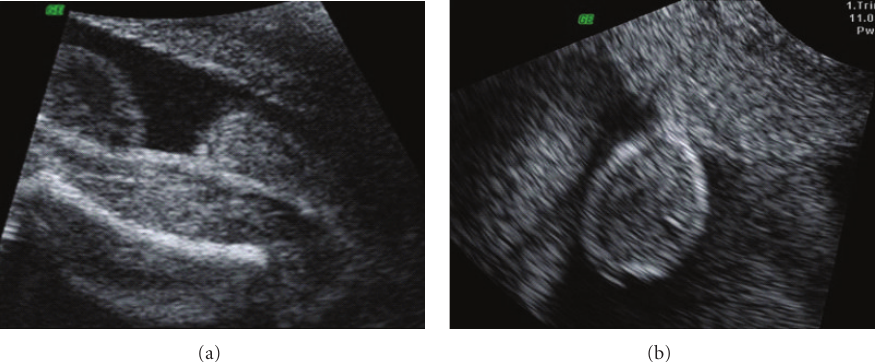
Figure 1: (a) and (b) Penoscrotal hypospadia assessed by two-dimensional ultrasound in the 27th week of pregnancy evaluated by abdominal approach, with clear visualization of scrotum and penis not visualized.